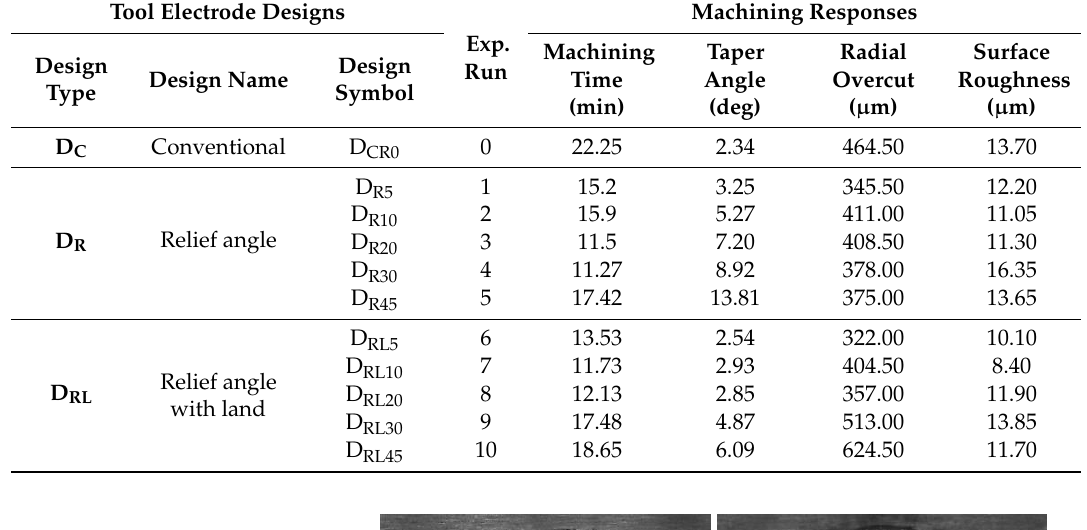
Table 4. Experimental results of EDM of D2 steel (1st stage of experimentation).